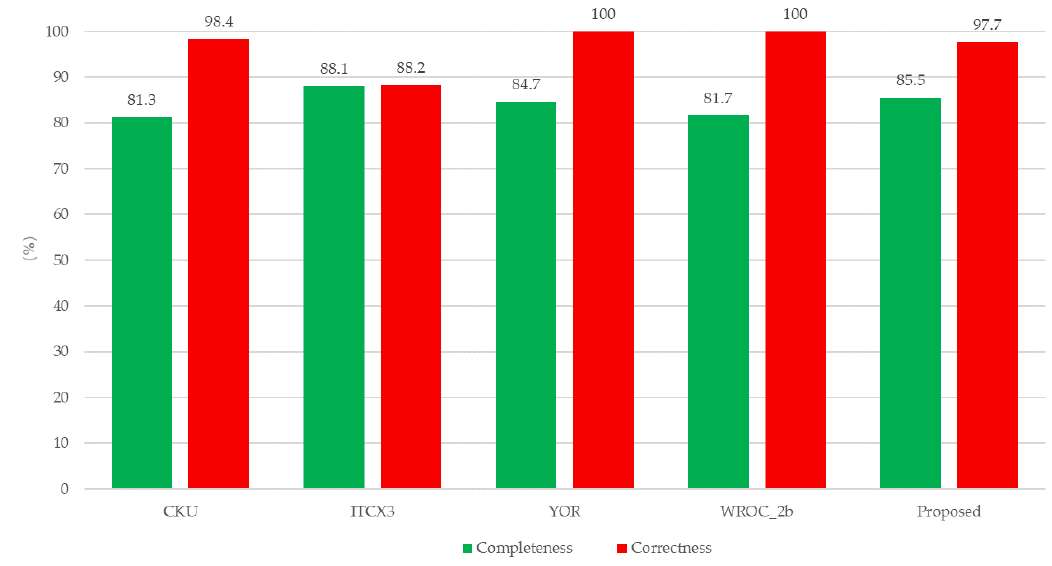
Figure 22. Comparison of all reconstruction roof planes with the four state-of-the-art methods on the ISPRS dataset. We use the same method name as the website described.